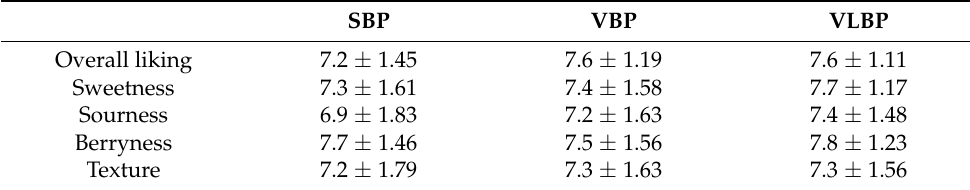
Table 2. Consumer ( n = 71) liking scores (average ± SD) of frozen blackcurrant products. 1 = I do not like at all, 9 = I like very much.